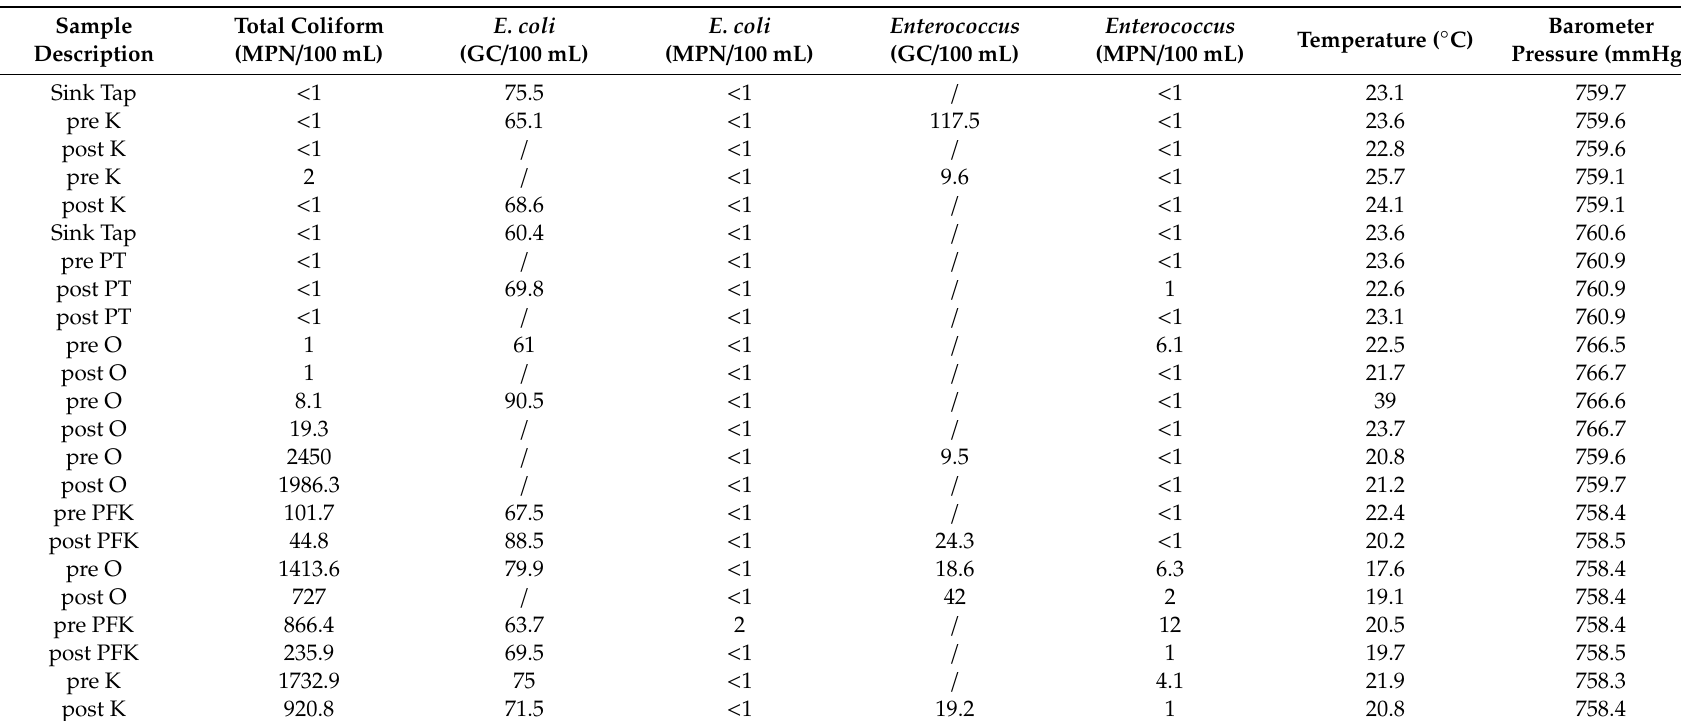
Table 1. Distribution of physical parameters by sample type (outside (O), inside kitchen (K), pressure tanks (PT), and post-filtration kitchen tap (PFK).